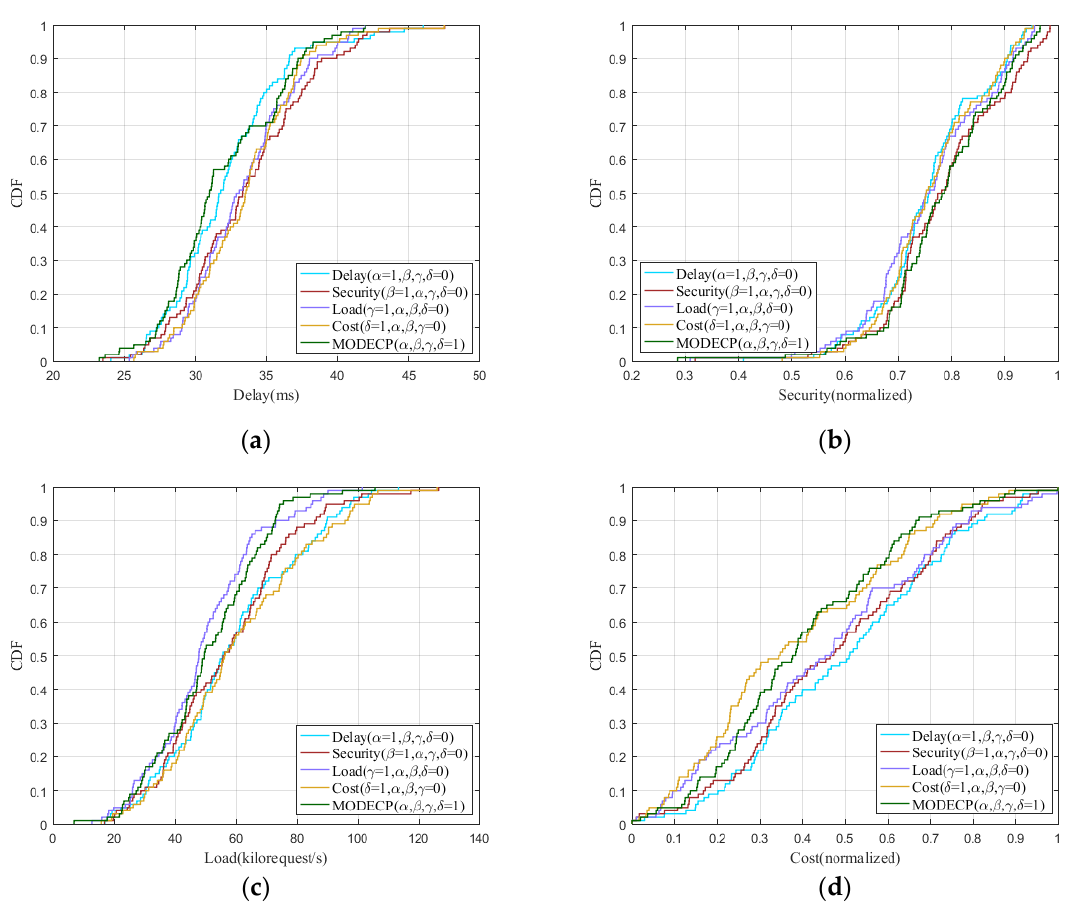
Figure 2. Cumulative distribution functions for different target states. ( a ) Performance of different states regarding end-to-end latency. ( b ) The performance of different states regarding node security. ( c ) The performance of different states regarding the control node load rate. ( d ) The performance of different states regarding the link overhead.